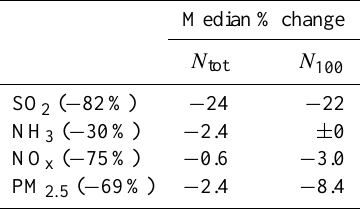
Table 3. Median percentage change in particle number concentra- tion over the whole model domain when one species is varied at the time within the MTFR